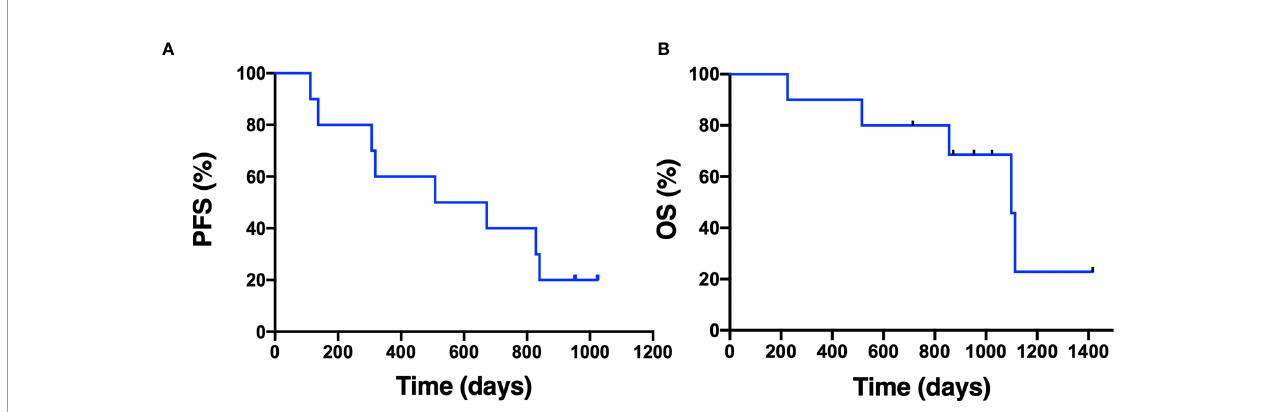
FIGURE 3 | Progression-free survival and overall survival. The Kaplan-Meier estimate for progression-free survival (A) and overall survival (B) is shown. Censored data are indicated by tick